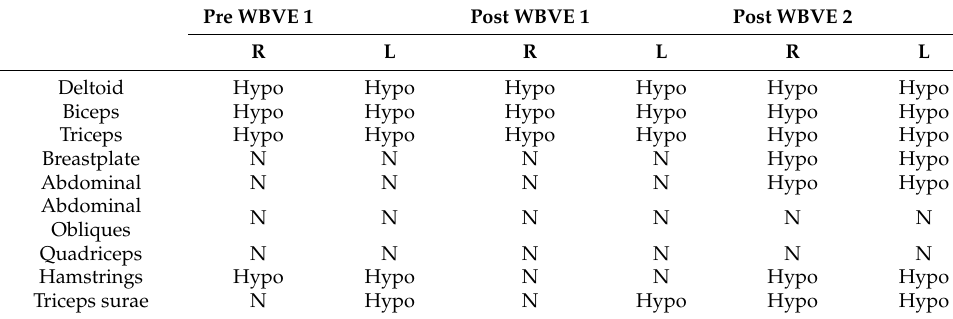
Table 3. WBVE results on tone assessed through muscle palpation.